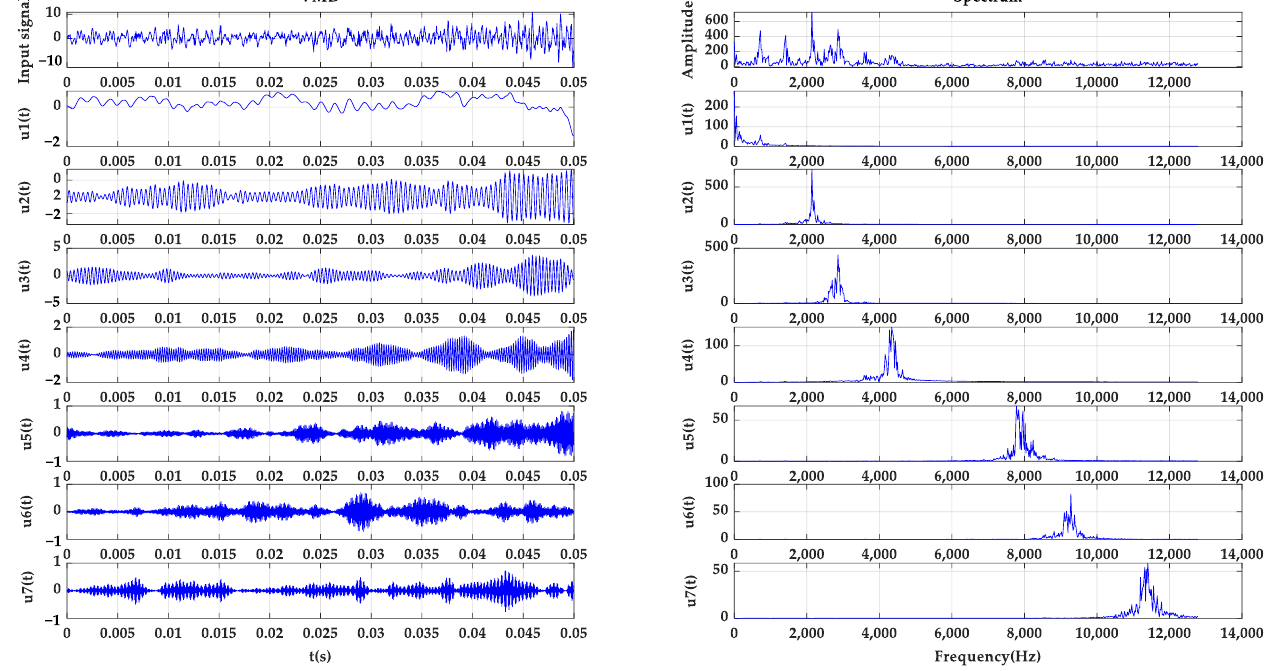
Table 4. Multiscale Fuzzy Entropy parameters for five kinds of fault.